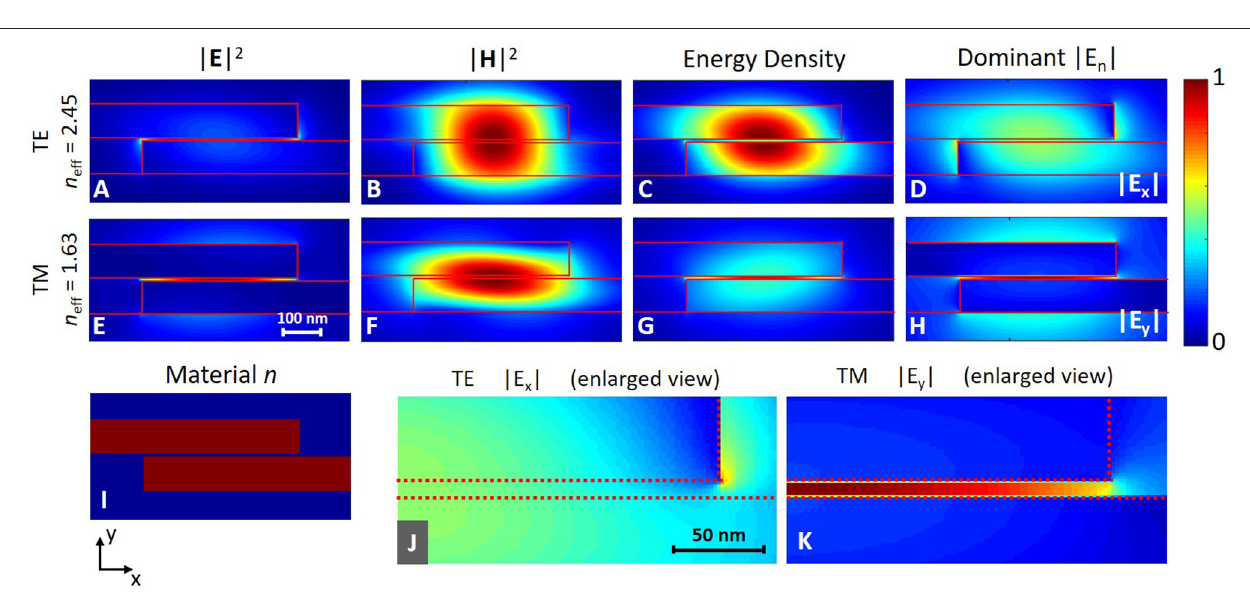
FIGURE 2 | TE and TM mode profiles (normalized, linear-scale) for horizontal-slot fin-waveguide. (A–H) shows the TE (TM) cross-sectional profiles for |E| 2 , |E| 2 , energy density and the dominant |E n | (|E X | for TE, |E Y | for TM) component. Waveguide width = 450nm. SiO 2 cladding ( n = 1.44). Fin-waveguide geometry outlined in red. (I) shows the material n profile, where red indicates n = 3.4, blue indicates n = 1.44. (J,K) shows an enlarged view of the dominant electric field component at the waveguide edge for the TE (TM) mode shown in (D,H) . For all profiles except (I) , max (red) to min (blue) are arbitrary